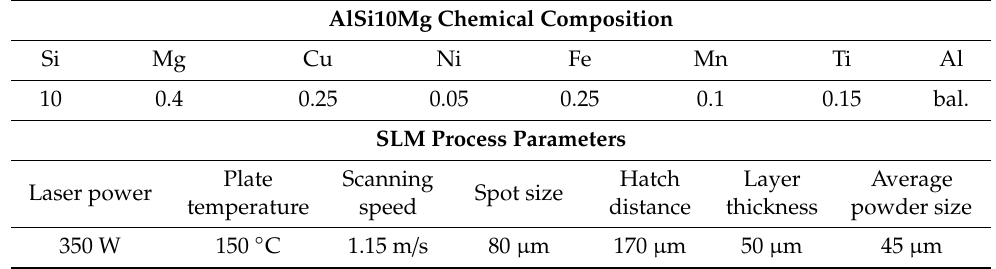
Table 1. AlSi10Mg powder (wt.%) chemical composition and selective laser melting (SLM) process